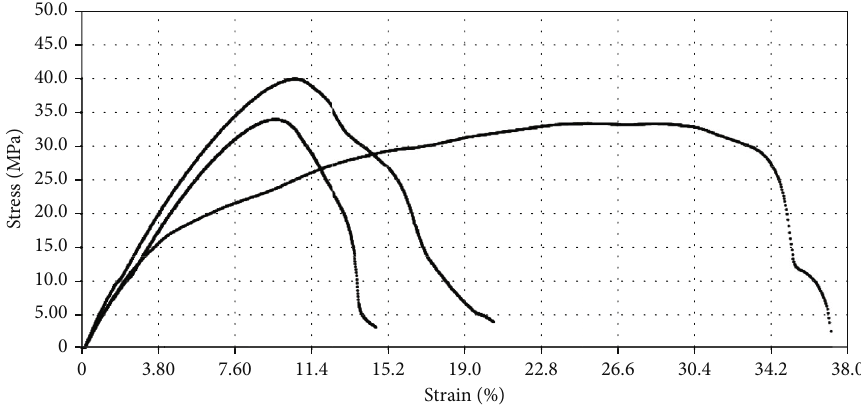
Figure 8: Stress and strain diagram for PEEK-CF.